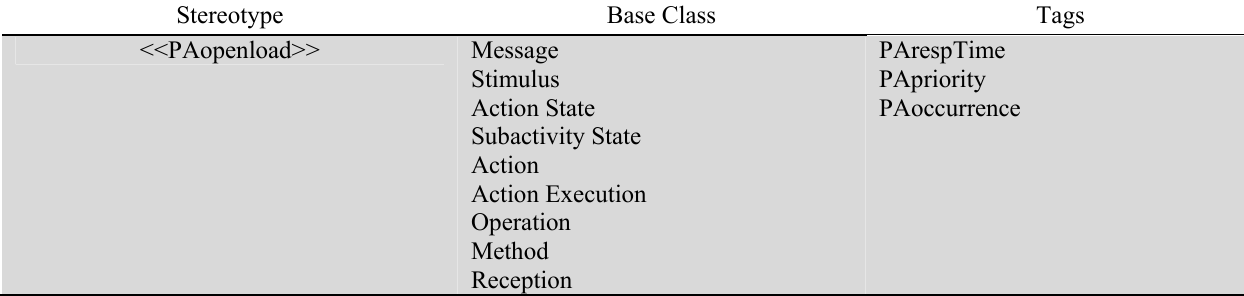
The cliché <<PAopenload>> with its labels